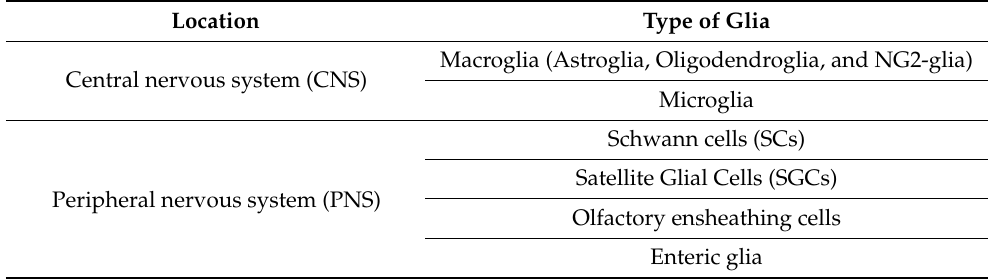
Table 3. Neuroglia